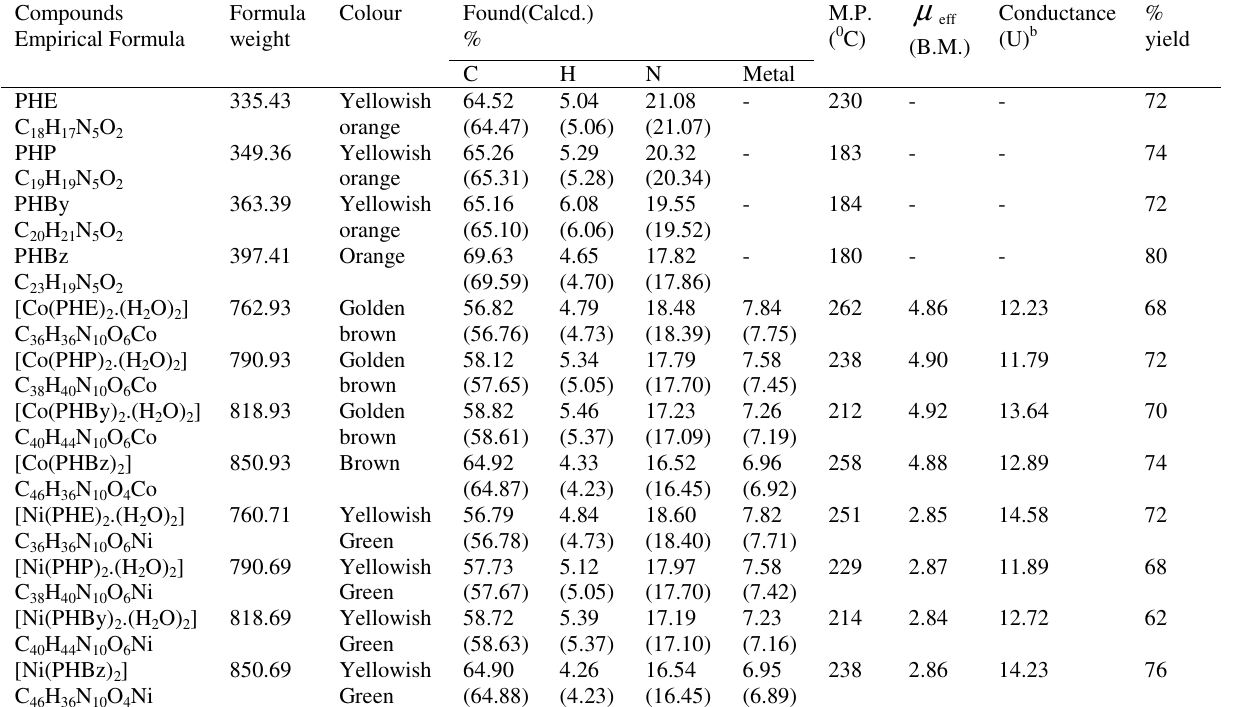
Table 1 . Physical and analytical data of hydrazone ligands and its Co II and Ni II